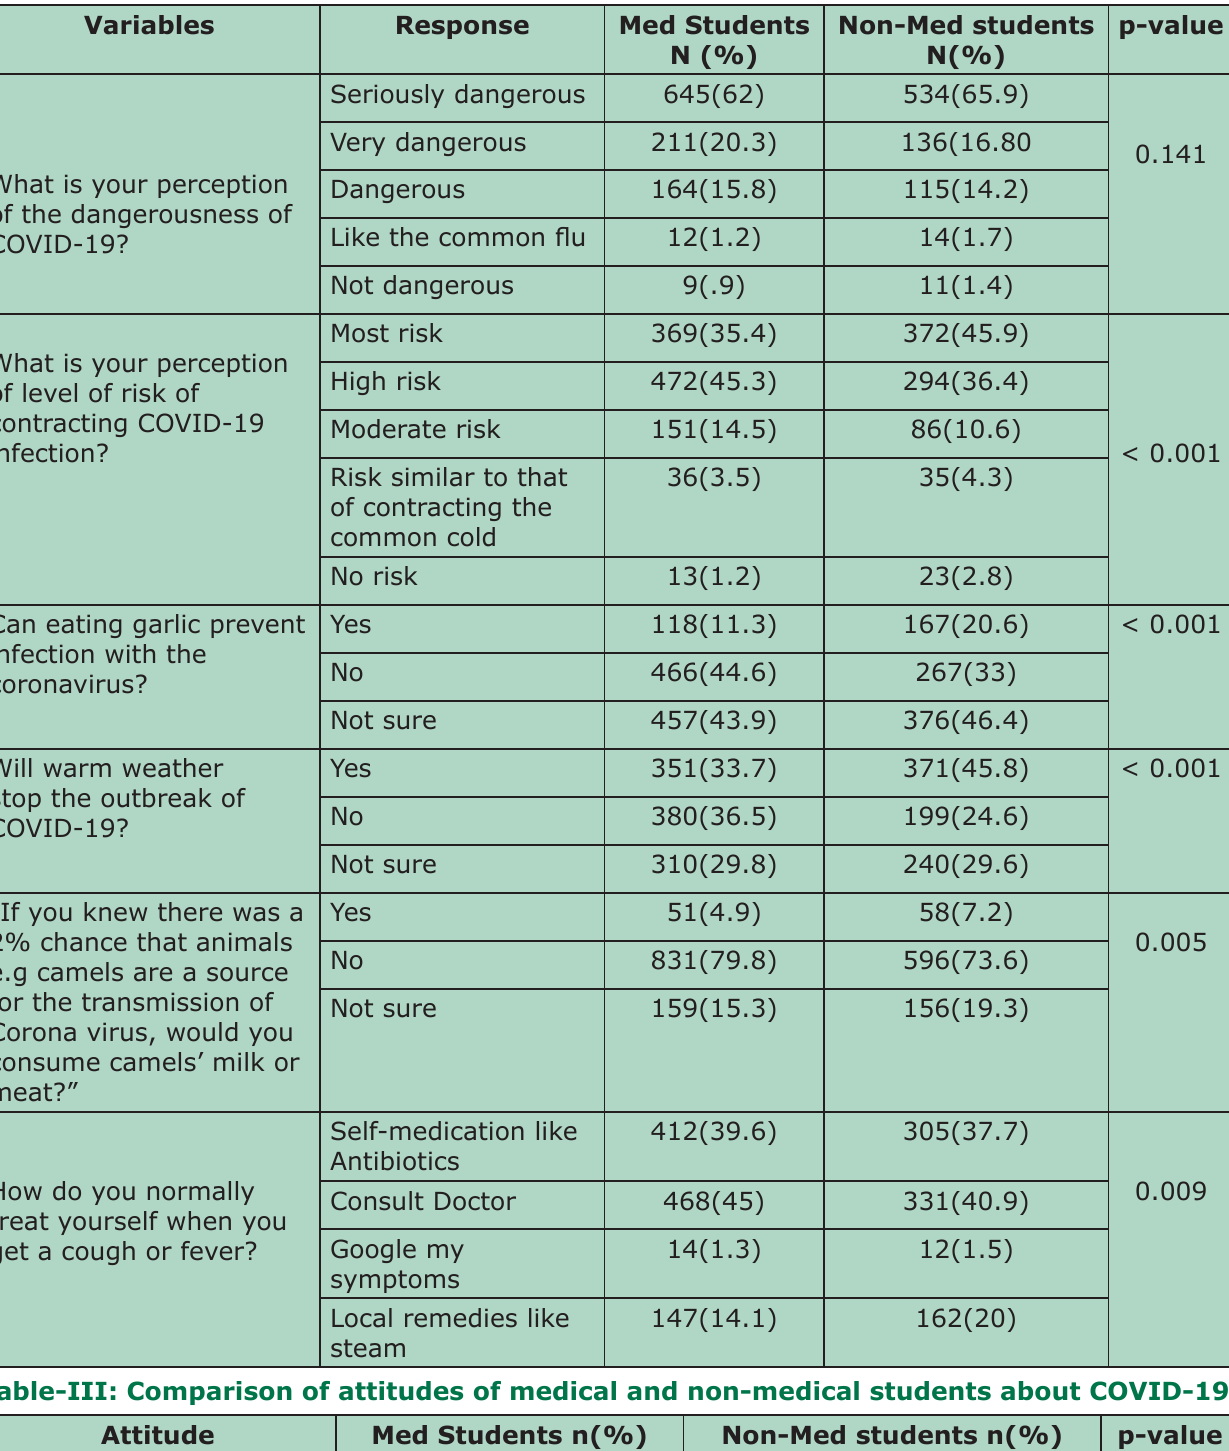
Table-II: Comparison of COVID-19 perception of various attitudes among medical and non-medical students.